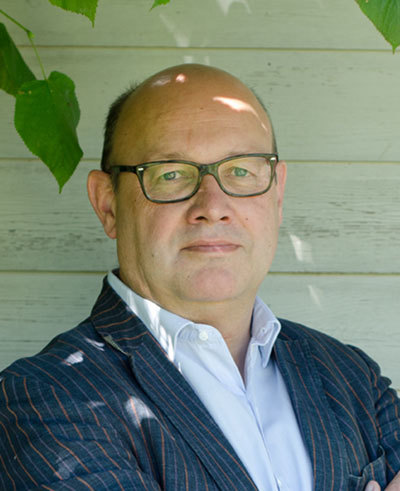
Luc van den Hauwe